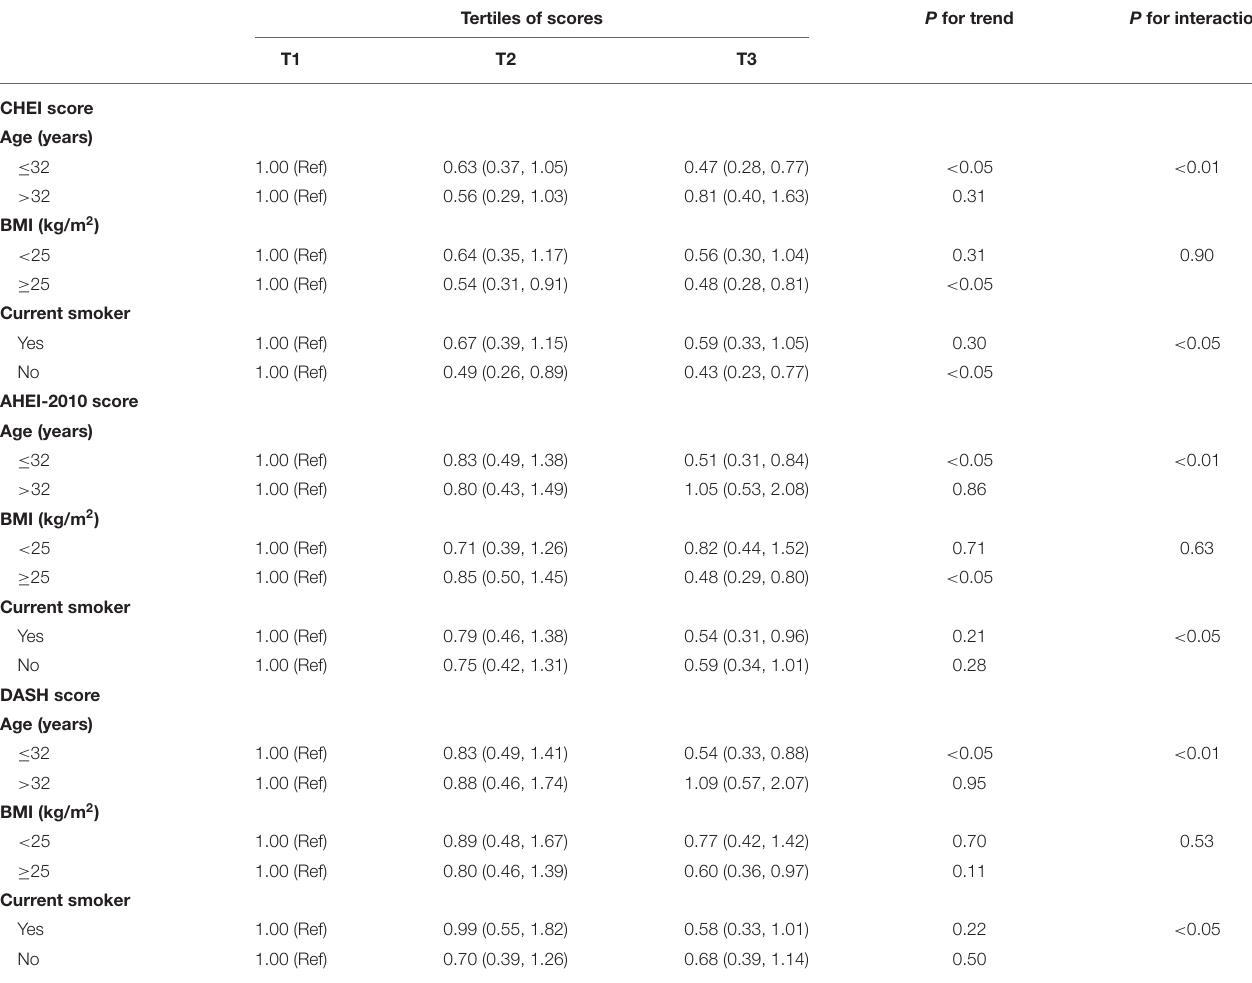
TABLE 3 | Adjusted OR and 95 % CIs for asthenoteratozoospermia risk by subgroup analyses a . Tertiles of scores P for